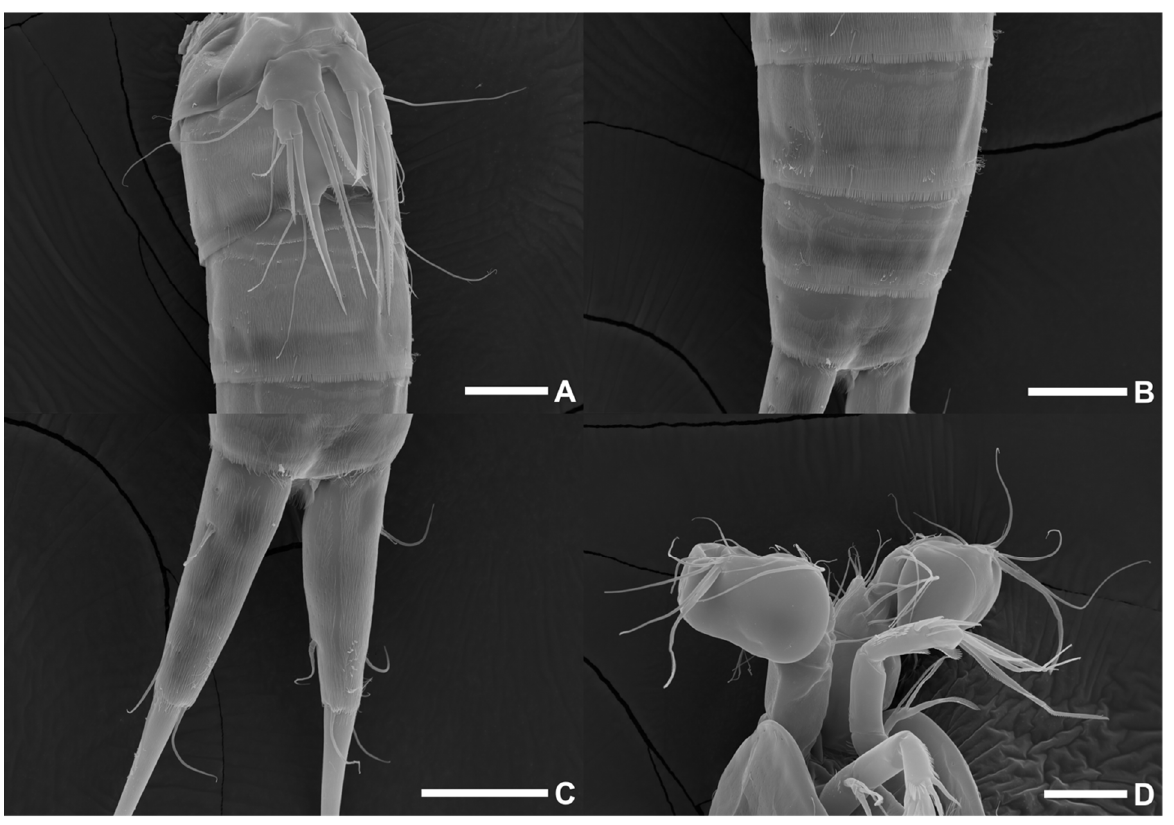
Figure 33. Scanning electron microscopy images of Phyllopodopsyllus similis sp. nov. male (paratype 24) in ventral view: ( A ) P5 and second to third urosomites; ( B ) fourth urosomite to anal somite; ( C ) caudal rami; ( D ) antennule and antenna. Scale bars: 30